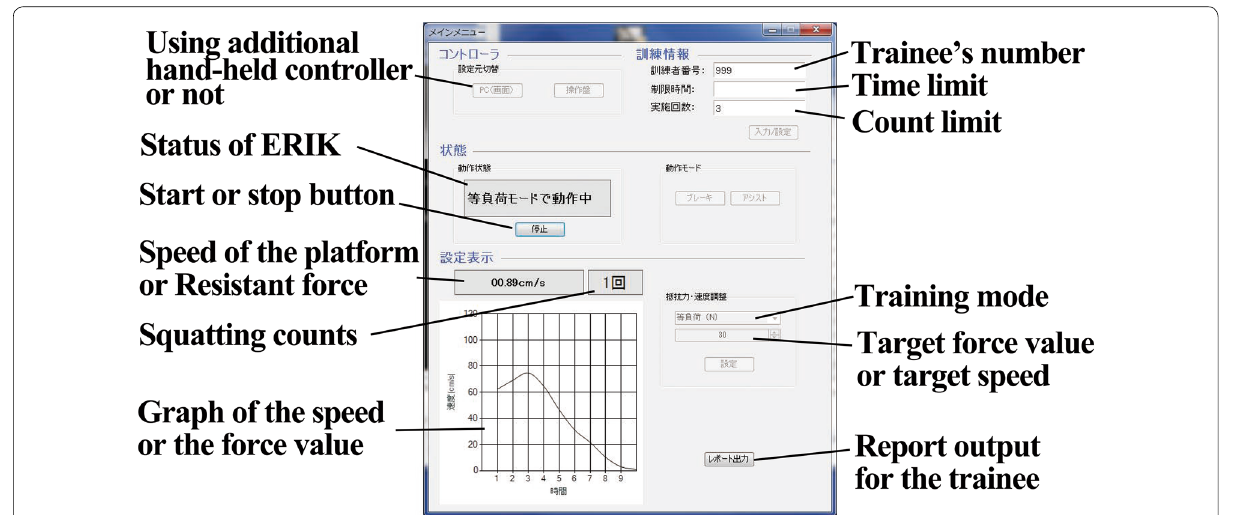
Fig. 9 Screen during exercise. Users can input the training condition on the same